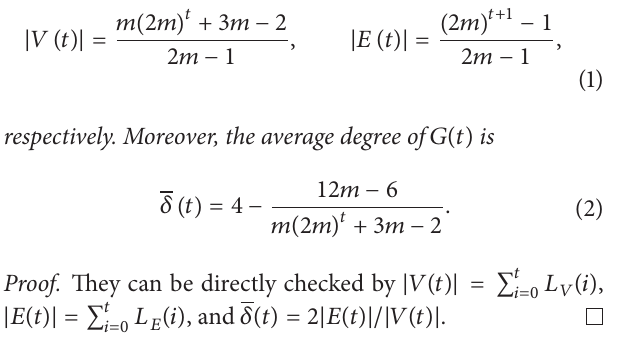
𝐿 (0) = 2 and 𝐿 (0) = 1 . From the above construction, it is 𝑉 𝐸 easy to see that 𝐿 𝑉 (𝑡) = 𝑚𝐿 𝐸 (𝑡 − 1) and 𝐿 𝐸 (𝑡) = 2𝑚𝐿 𝐸 (𝑡 − 1) , 𝑡 which give rise to 𝐿 𝐸 (𝑡) = (2𝑚) and 𝐿 𝑉 (𝑡) = 𝑚(2𝑚)